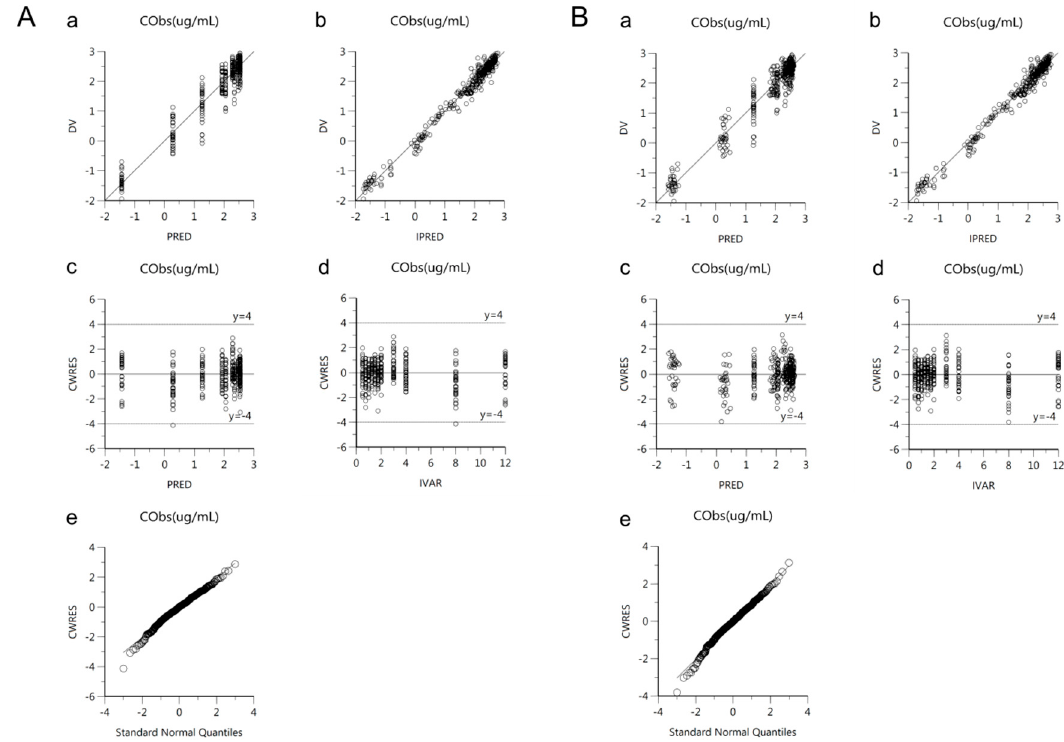
Figure 2. Goodness-of-fit plots of base model ( A ) and final model ( B ) for cis -cefprozil. ( a ) Observed plasma concentrations (DV) against population predicted concentrations (PRED); ( b ) Observed plasma concentrations (DV) against individual predicted concentrations (IPRED); ( c ) Conditional weighted residuals (CWRES) against population predicted concentration (PRED); ( d ) Conditional weighted residuals (CWRES) against time (IVAR); ( e ) Quantile-quantile plot of components of conditional weighted residuals.